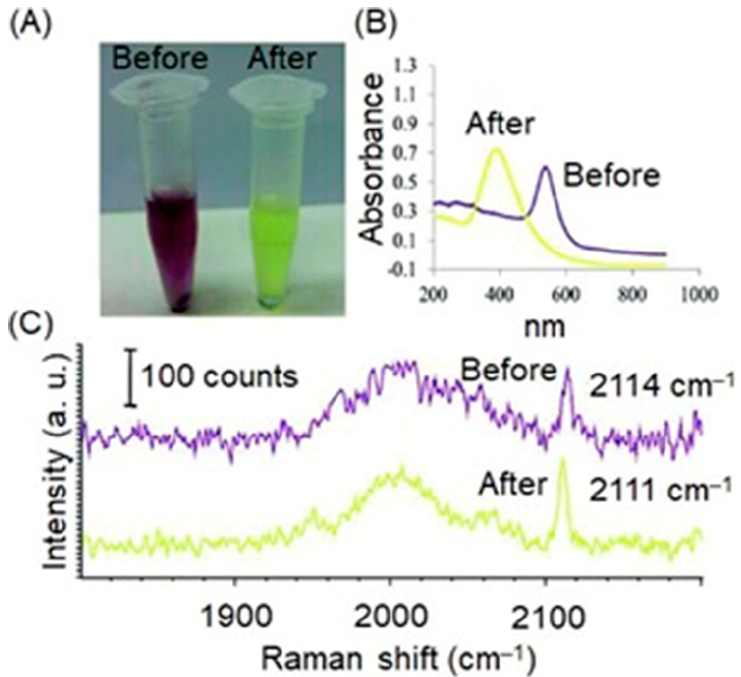
Figure 40. ( A ) Photographs of the probe (purple solution) and after addition of cysteine to the probe (yellow solution). ( B ) UV–visible spectra and ( C ) SERS spectra of 1 mM probe before (purple) and after (yellow) the addition of 1 mM cysteine. Adapted with permission of the Royal Society of Chemistry, from Dual-mode biosensor combining transition metal carbonyl-based SERS and colorimetric readout for thiol detection, Lin, D.; Zhou, J.; Yu, Y.; Chen, W.; Liao, P.-H.; Huang, H.; Kong, K. V. 11 , 41, 2019 ; permission conveyed through Copyright Clearance Center, Inc. [347].